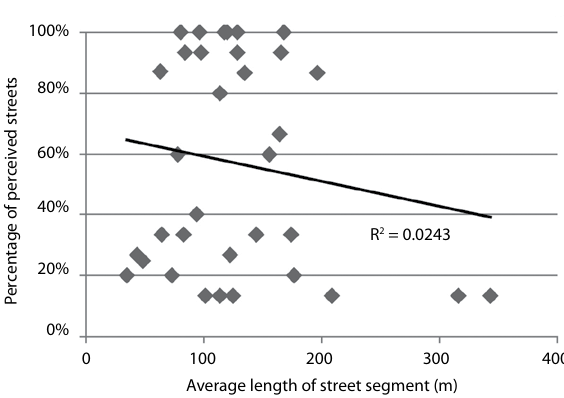
fig. 8. Comparison chart between average length of street segment and percentage of perceived streets in Kenmore and Kendall